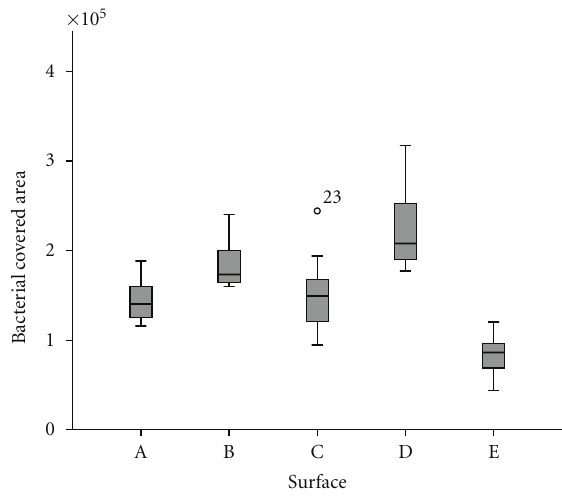
Figure 9: Quantification of bacterial adhesion ( Streptococcus mutans ) on glass coated with nonhexylated polymer (A), glass coat- ed with hexylated polymer (B), glass coated with hexylated polymer and spin coated with amorphous silicon dioxide (C1 = middle; C2 = border), glass coated with hexylated polymer and spin coated with nanoporous silicon dioxide (D), and untreated glass (E); significant di ff erences ( P ≤ 0 . 05) shown between all surface modifications and untreated glass or between surface A, C in comparison to D